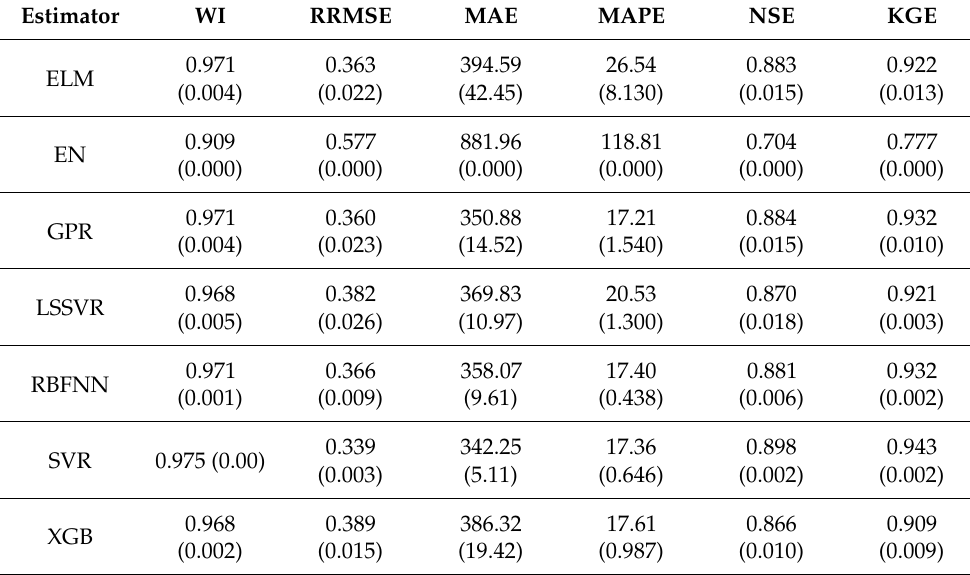
Table 8. Model results for Case 2.